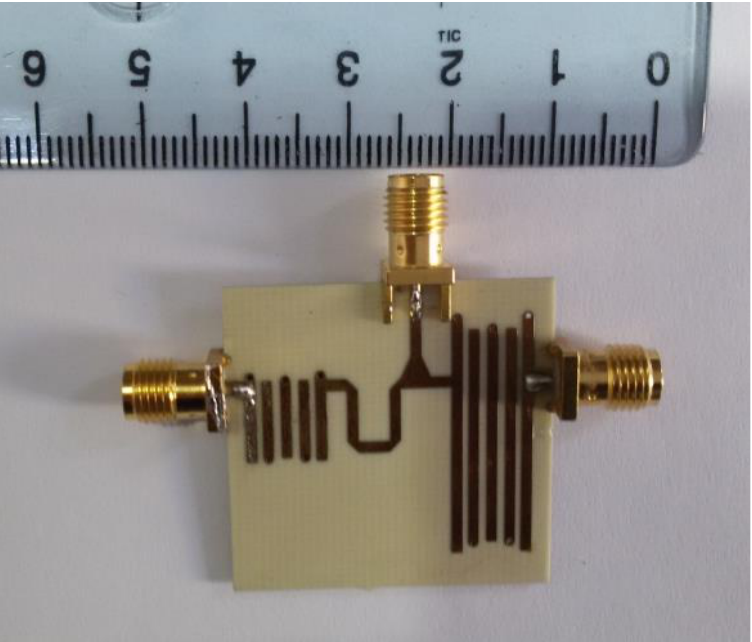
Figure 12. Fabricated photo of the proposed microstrip diplexer with two fifth-order interdigital BPFs.